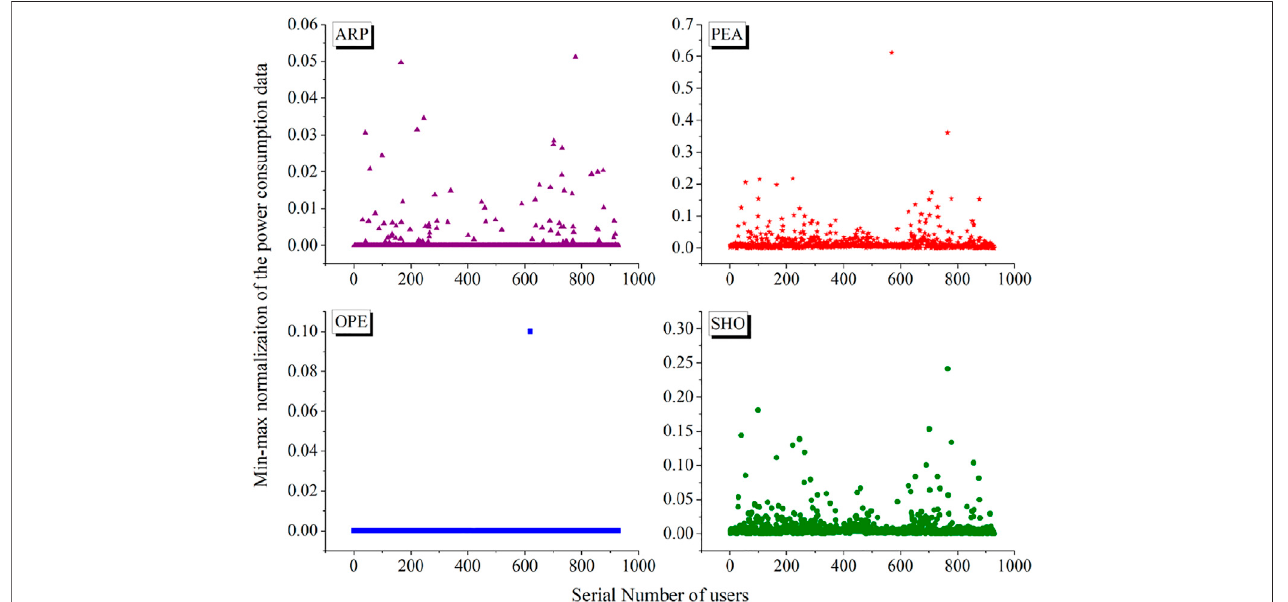
FIGURE 3 | Statistical descriptive plots of the power consumption data in different time period partitions.